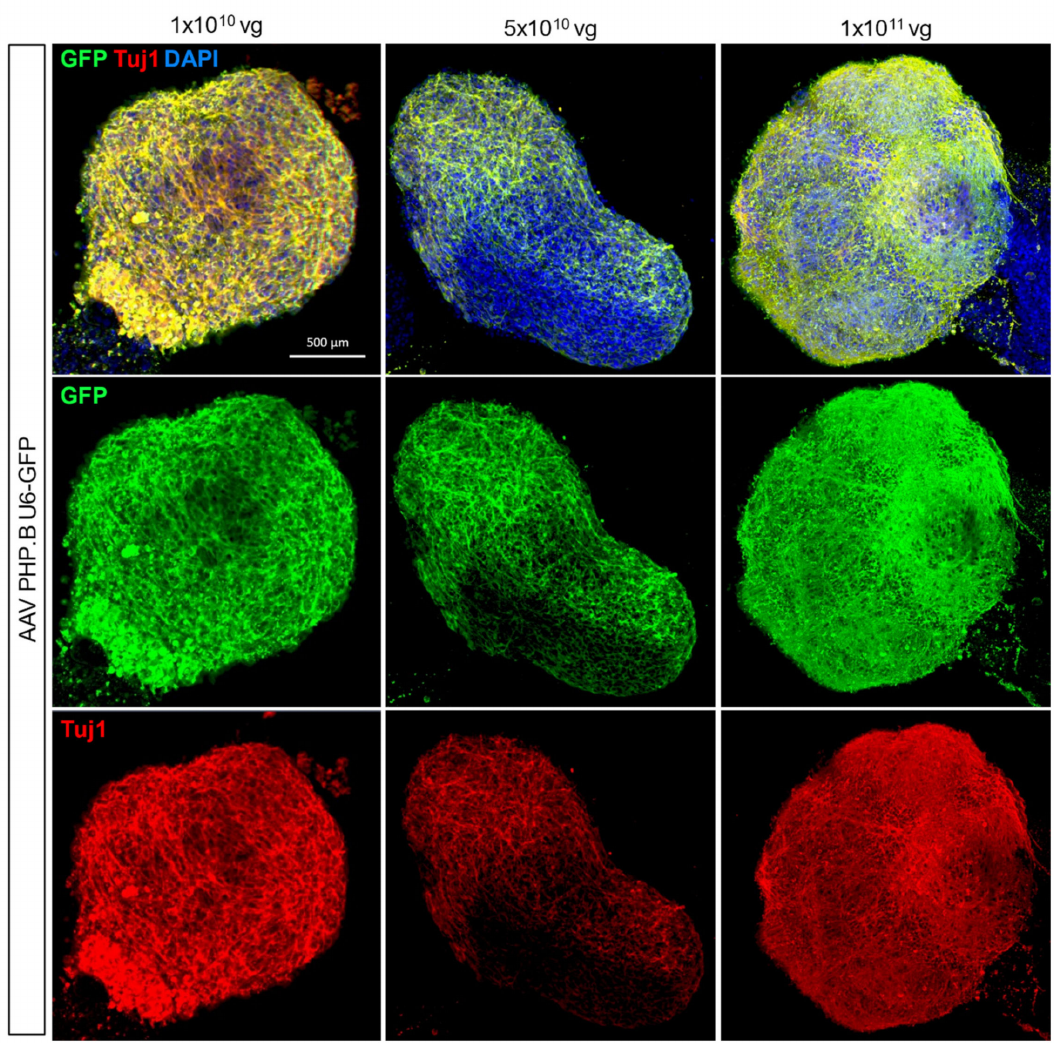
Figure 2. AAV-mediated gene delivery in human cortical organoids. 3 different titres (1 × 10 10 , 5 × 10 10 and 1 × 10 11 vg per organoid) of a AAV for ubiquitous GFP expression were tested and analysed by whole-mount immunostaining. GFP expression, neuronal marker (Tuj1) and nuclei (DAPI) were co-stained. Scale bar is 500 µ